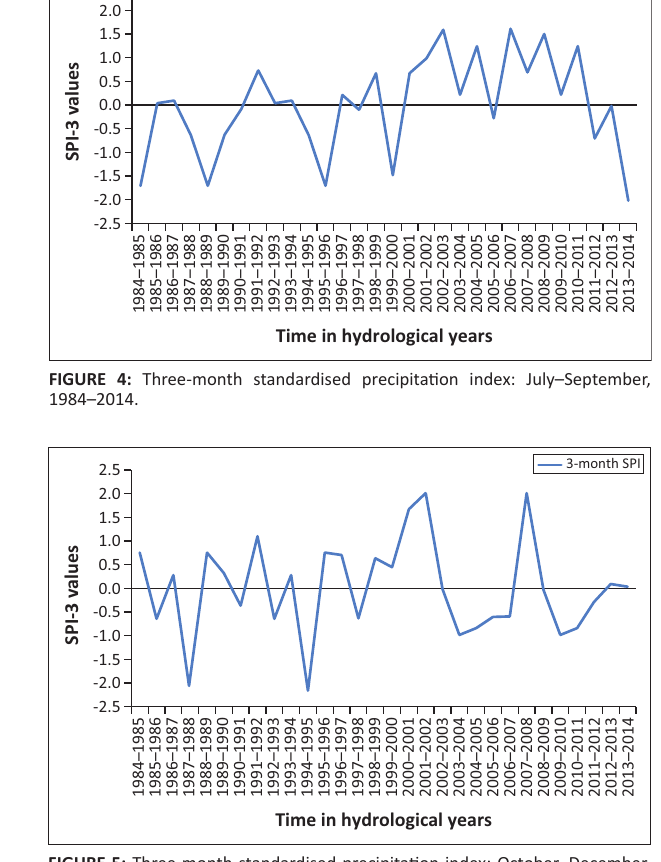
FIGURE 3: Three-month standardised precipitation index: April–June, 1984– 2014.